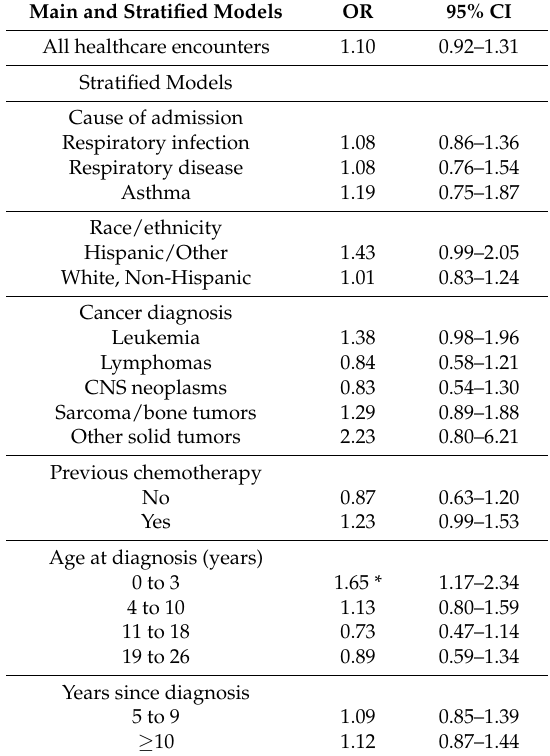
Table A1. Adjusted odds ratios and 95% confidence intervals (CI) for the association of a 10-unit increase in PM 2.5 with any respiratory healthcare encounter among survivors of childhood